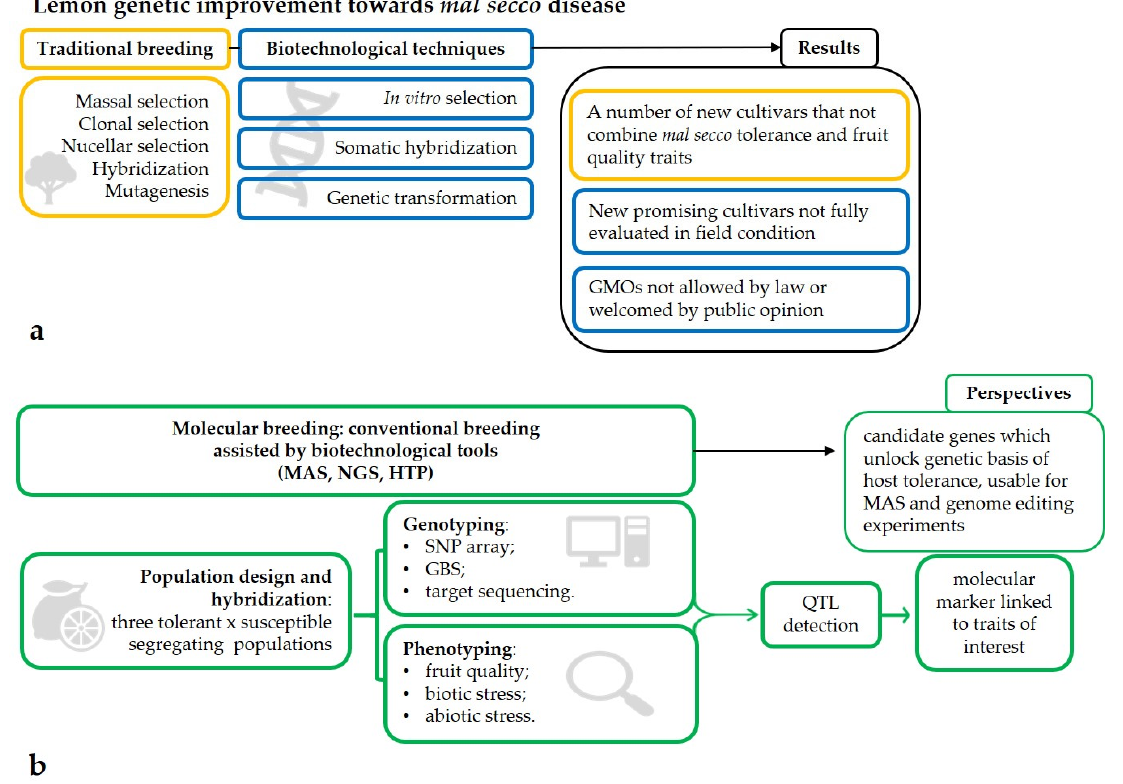
Figure 1. A schematic view of lemon breeding techniques used in the past and supposed to be used in the next future to obtain genotypes with enhanced resistance to mal secco disease and their respective results: ( a ) traditional and biotechnological techniques led to the obtainment of new selections which did not combine mal secco tolerance and fruit quality traits, whose tolerance has not been fully demonstrated in field conditions, or which use is hampered because Genetically Modified Organisms; ( b ) molecular breeding strategies combining hybridization and high-throughput genotyping and phenotyping in a marker-trait association analysis will hopefully lead to the identification of candidate genes linked to mal secco tolerance.